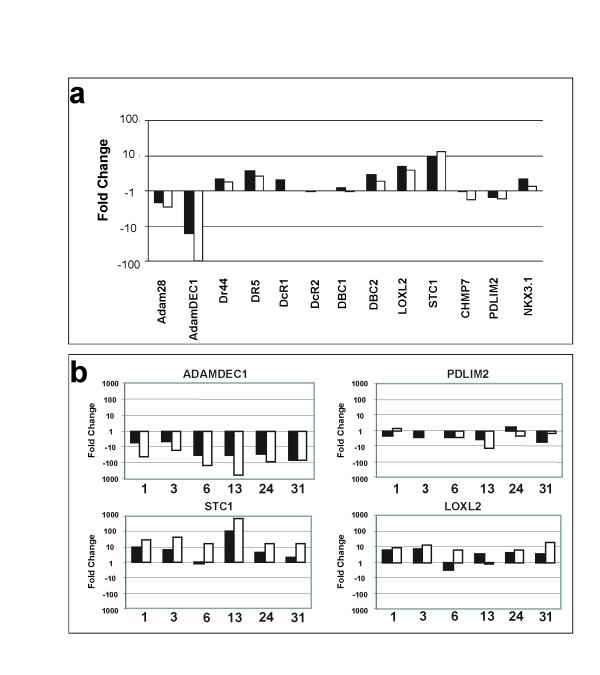
mRNA gene expression analyses for 13 genes. a. Fold change gene expression in colon tumour (black) and liver metastases (white) relative to colon normal. Gene expression was expressed as the change in Ct of the gene of interest compared to the 18s control (dCt) and relative expression calculated using the comparative CT method with fold change (2-ddCt). Fold change is shown on a logarithmic scale. b. Fold change gene expression of colorectal tumours (black) and liver metastases (white) relative to the matched colon normal. Fold change is presented on a logarithmic scale and was calculated as above.